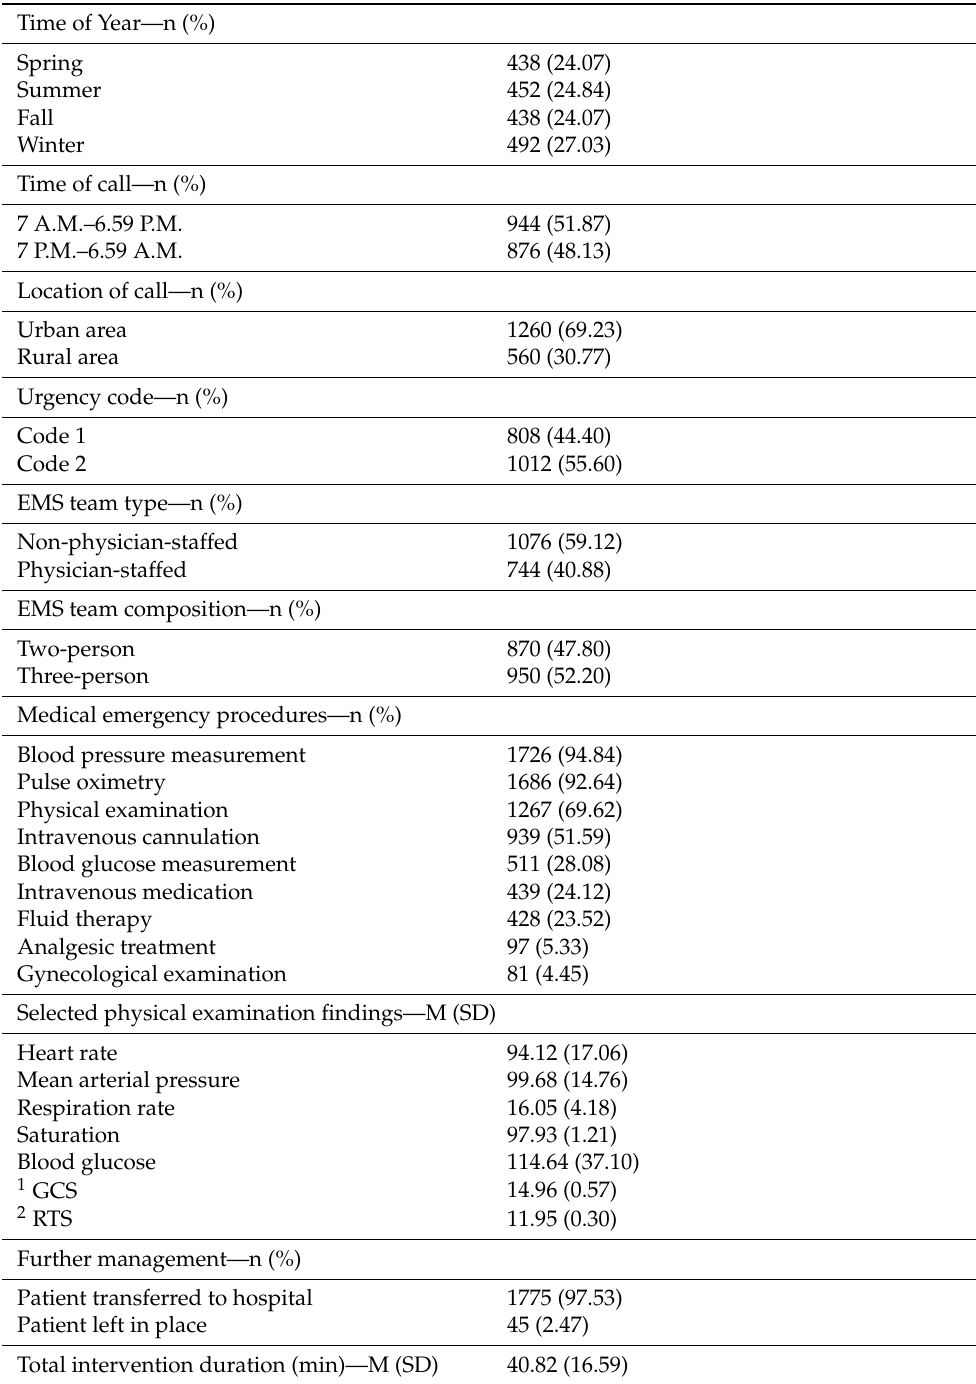
Table 2. Characteristics of EMS team